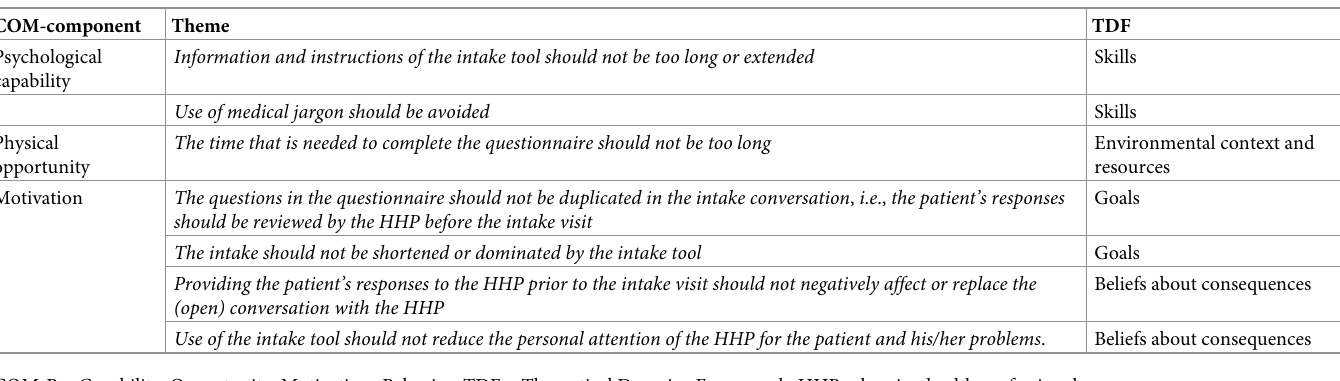
Table 5. Identified barriers to the use of the ICF-based intake tool as perceived by patients. COM-component